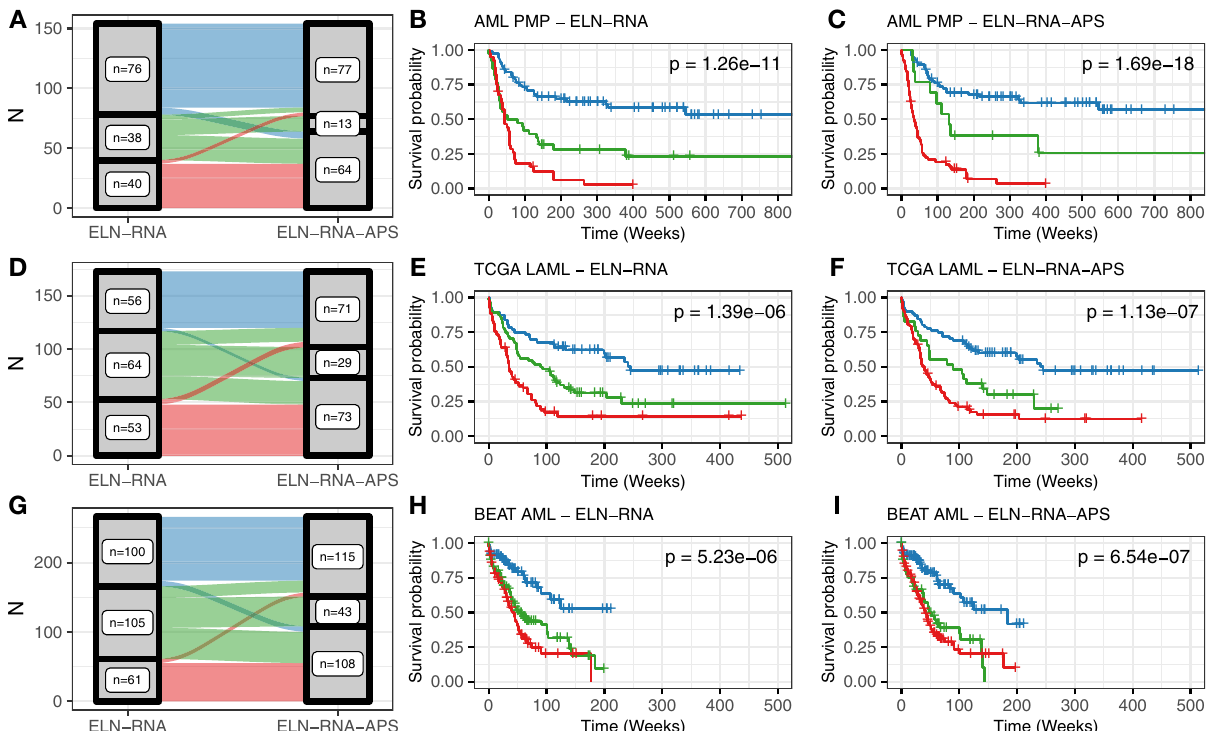
Fig. 5 Patient strati fi cation. A Comparison of patient strati fi cation by ELN-RNA and ELN-RNA-APS models for the AML PMP cohort. The width of each link is scaled to the number of patients shared between each set of risk categories. B – C Survival curves for the ELN-RNA and ELN-RNA-APS models for the AML PMP cohort. D – I Strati fi cation and survival curves for the TCGA LAML and Beat AML patient cohorts. Patient groups are colored as in Fig. 4D (favorable — blue, intermediate — green, adverse — red), with log-rank p values